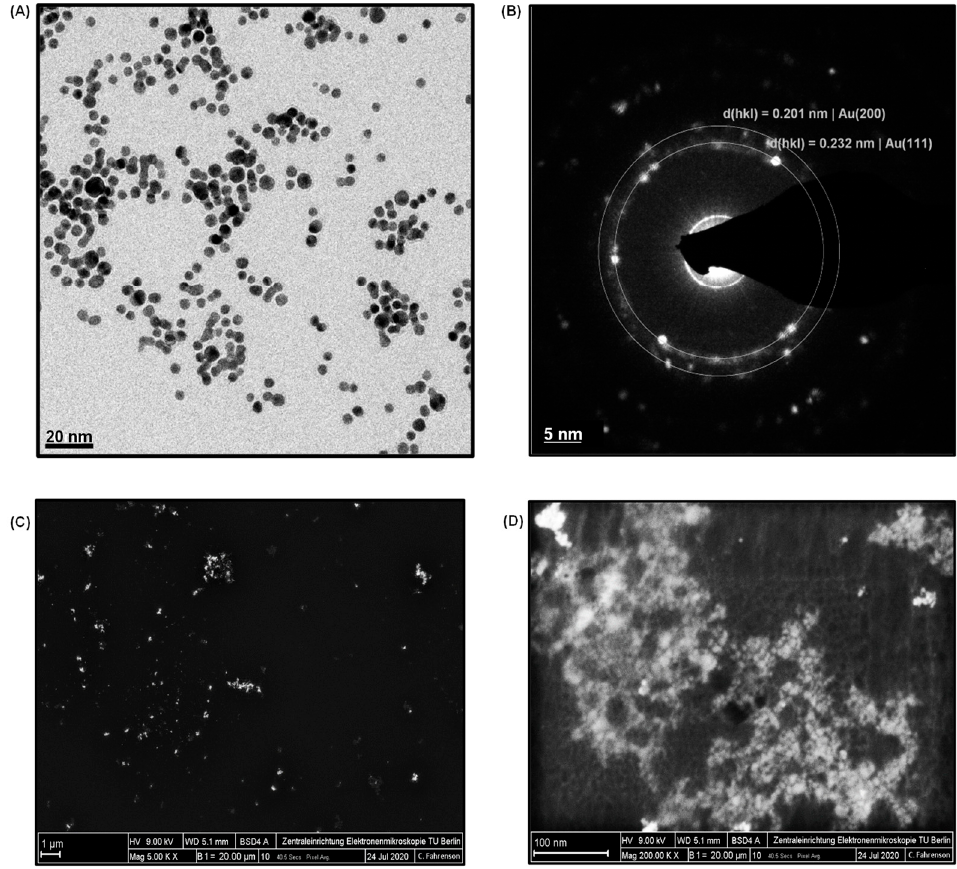
Figure 2. ( A ) TEM image of AuNPs. ( B ) XRD image of AuNPs. ( C ) SEM image of AuNPs at 5000× magnification. ( D ) SEM image of AuNPs at 200,000× magnification.